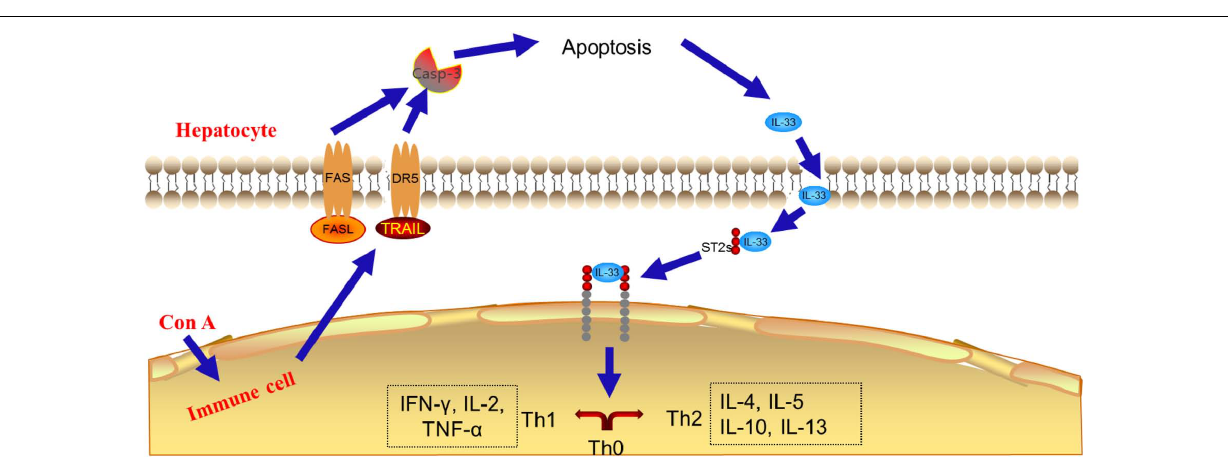
Then, the pharmacological effect of SCG on Con A-induced liver injury was demonstrated. The results showed the pharmacological effect of SCG on Con A-induced liver injury by decreasing the serum level of ALT and AST, relieving the pathological changes of liver tissue, and balancing the pro and anti-inflammatory cytokines.